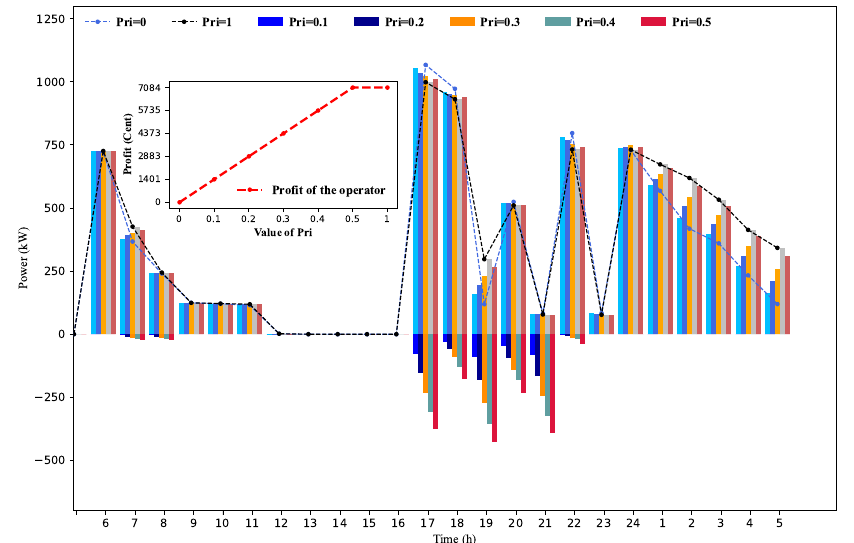
Figure 8. Simulation results of the EV charging/discharging loads with different Pr i ’s; the total cost profit improvement is shown in the small